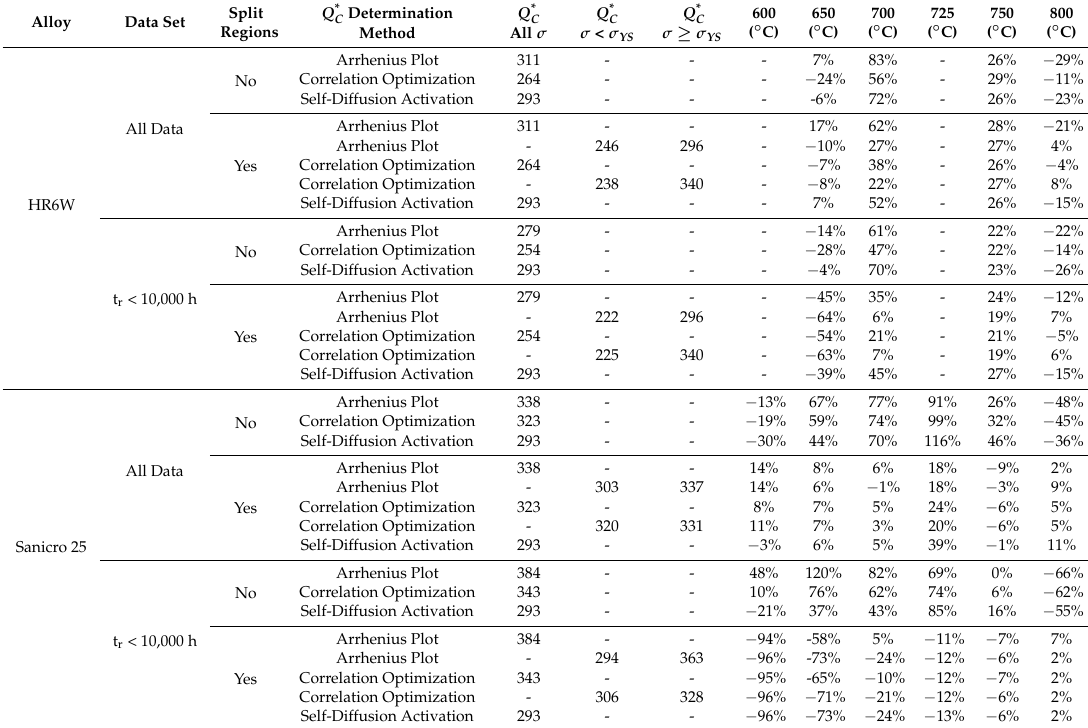
Table 5. Average percentage difference of calculated and experimental rupture